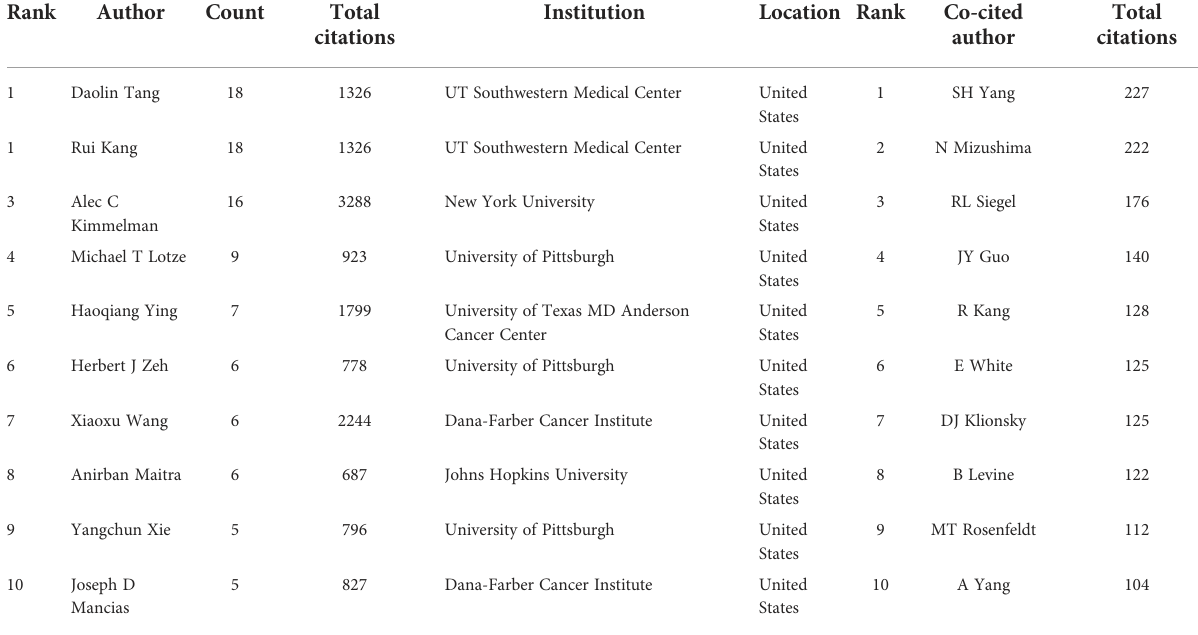
TABLE 5 The top 10 authors and most co-cited authors in the fi eld of autophagy and pancreatic cancer.